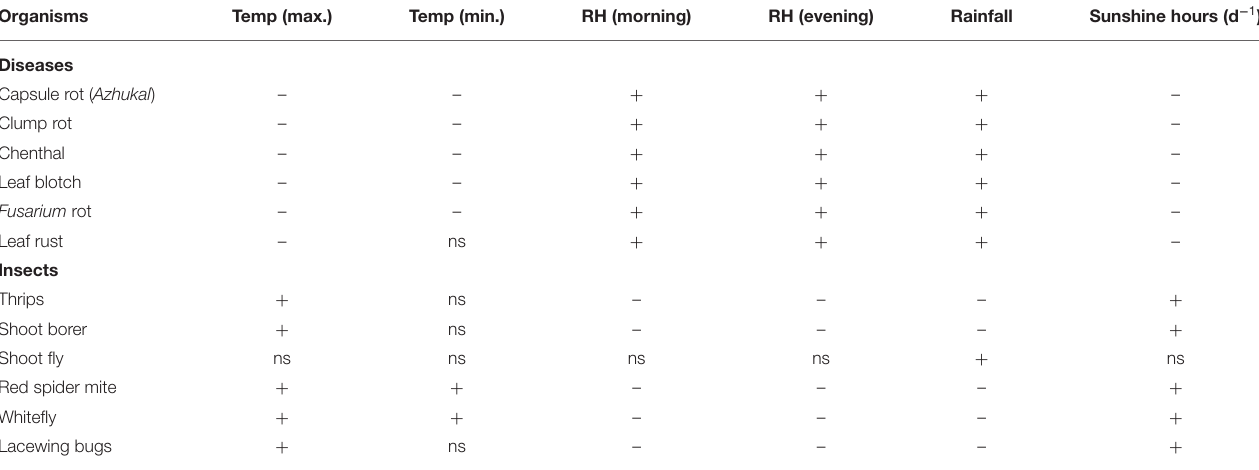
TABLE 2 | Major diseases and insect pests on cardamom and its correlation with climatic factors. Organisms Temp (max.)